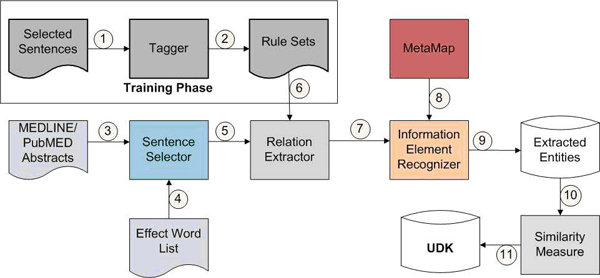
Data flow of MKEM